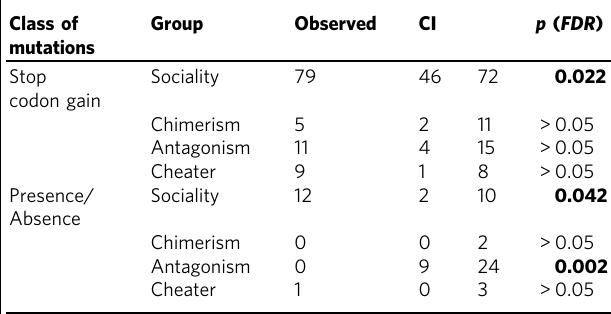
Table 3 Enrichment analysis of the number of social genes carrying at least one mutation that introduces a stop